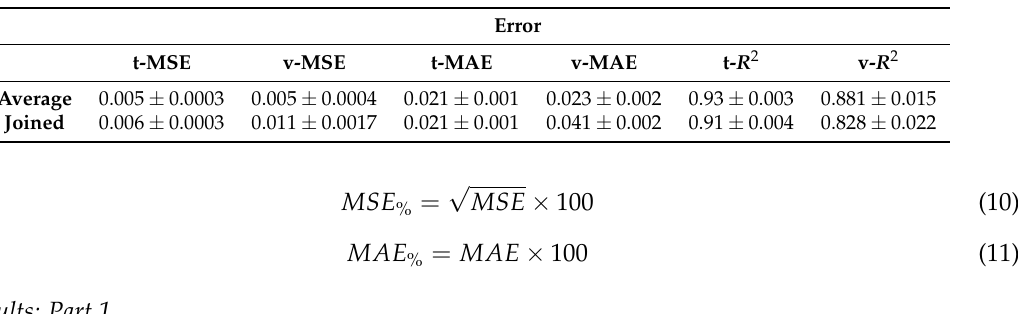
Table 3. The average error across every subject in the dataset and the error obtained when learning in the joined dataset. To convert these errors into percentages (except R 2 ), the equations for MSE and MAE are given in Equations (10) and (11), respectively. Individual errors for each subject are shown in Figure